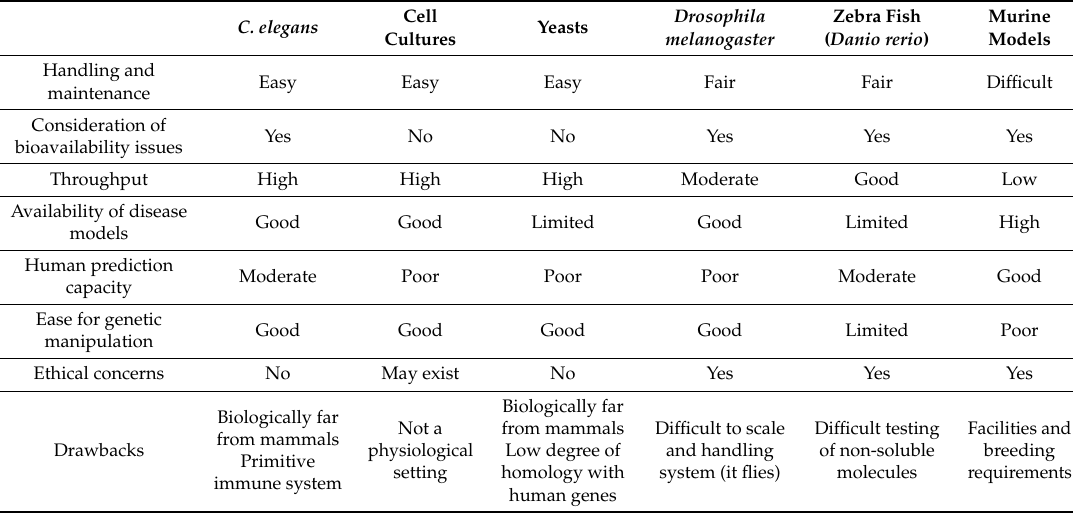
Table 2. Main characteristics of di ff erent ex vivo and in vivo models (information adapted and extended from Calvo et al.